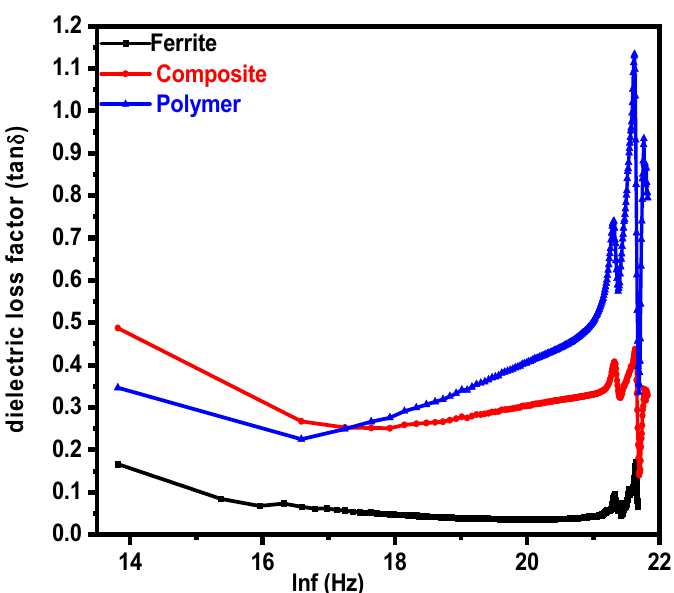
Figure 4. Dielectric loss factor of Y-type hexaferrite Sr 2 Co 2 Fe 12 O 22 ,composite (Sr 2 Co 2 Fe 12 O 22 + PPy-DBSA) and polymer PPy-DBSA.